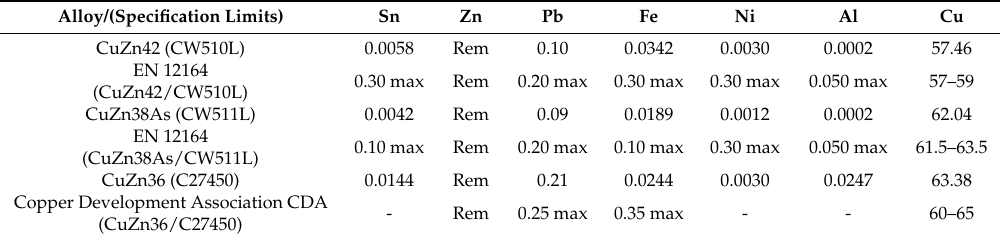
Table 1. Chemical composition of the studied brass alloys (expressed in wt.